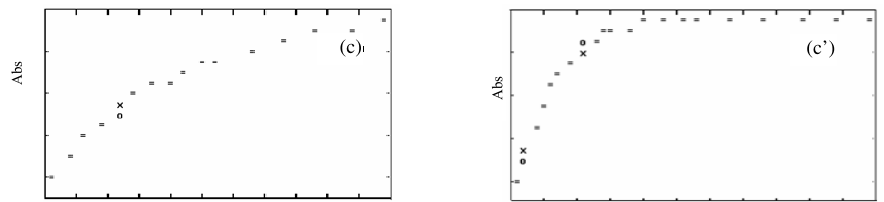
Figure 2. UV-Vis spectra for titration of BHABD (a) and BSAPD (a´ ) (3.8 × 10 -5 M) with Co 2+ ion in acetonitrile (T = 25 ˚C, I= 0.05 M and 0.05M TEAP) and the corresponding absorbtion mole ratio curves at 372, 272 nm respectively (b,b ΄ ) and curve fitting(c,c ΄ )